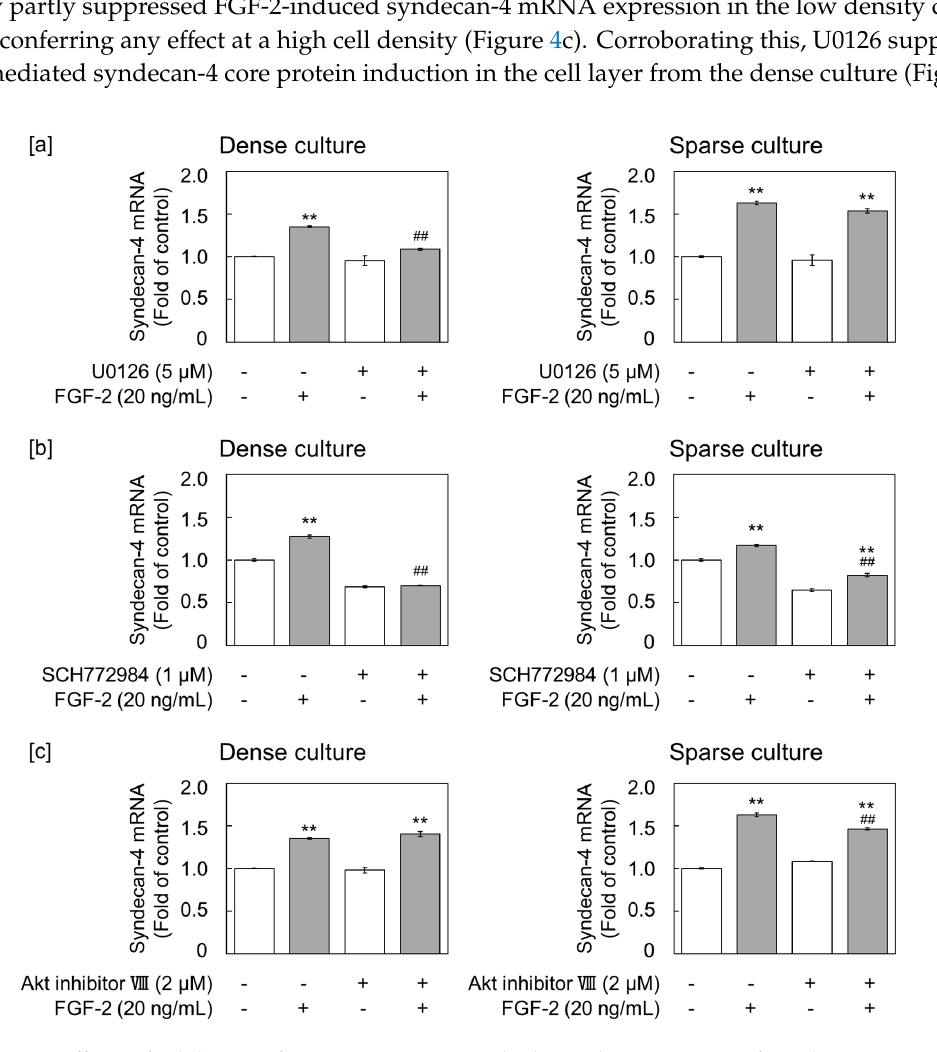
Figure 4. E ff ects of inhibition of MEK1 / 2, ERK1 / 2, and Akt on the expression of syndecan-4 mRNA in dense and sparse cultures of vascular endothelial cells. Vascular endothelial cells in dense and sparse cultures were pretreated with the ( a ) 5 µ M MEK1 / 2 inhibitor U0126, ( b ) 1 µ M ERK1 / 2 inhibitor SCH772984, or ( c ) 2 µ M Akt inhibitor (Akt inhibitor VIII) at 37 ◦ C for 3 h, followed by stimulation with or without 20 ng / mL FGF-2 for 6 h. The syndecan-4 mRNA level was quantified using qRT-PCR. Values represent the mean ± S.E. of four technical replicates. ** p < 0.01, significantly di ff erent from the corresponding treatment without FGF-2; ## p < 0.01, significantly di ff erent from the corresponding inhibitor